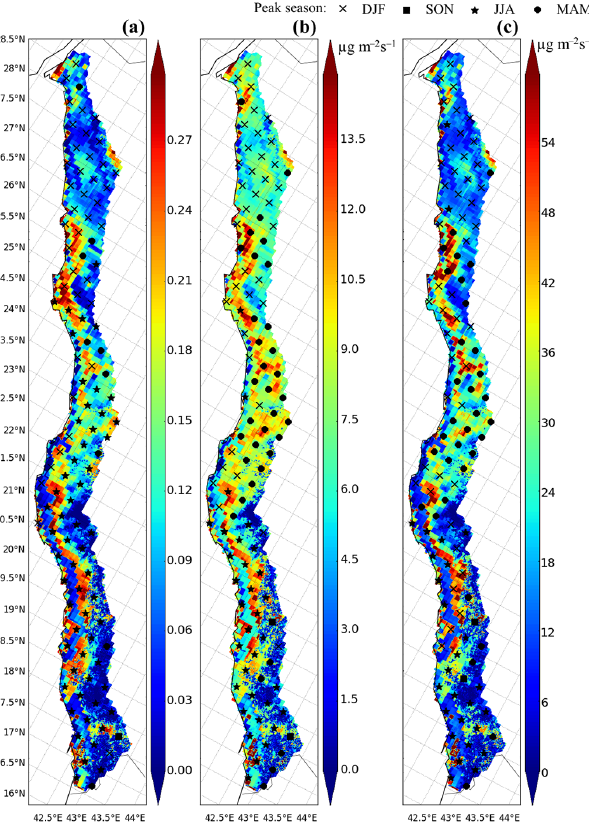
Figure 5. Average 2009–2011 (a) dust event frequency, (b) average emission intensity (µgm − 2 s − 1 ), and (c) yearly maximum emis- sion rate (µgm − 2 s − 1 ) in 1kmALL experiment with SEVIRI source function. Peak season is indicated by symbols (see figure